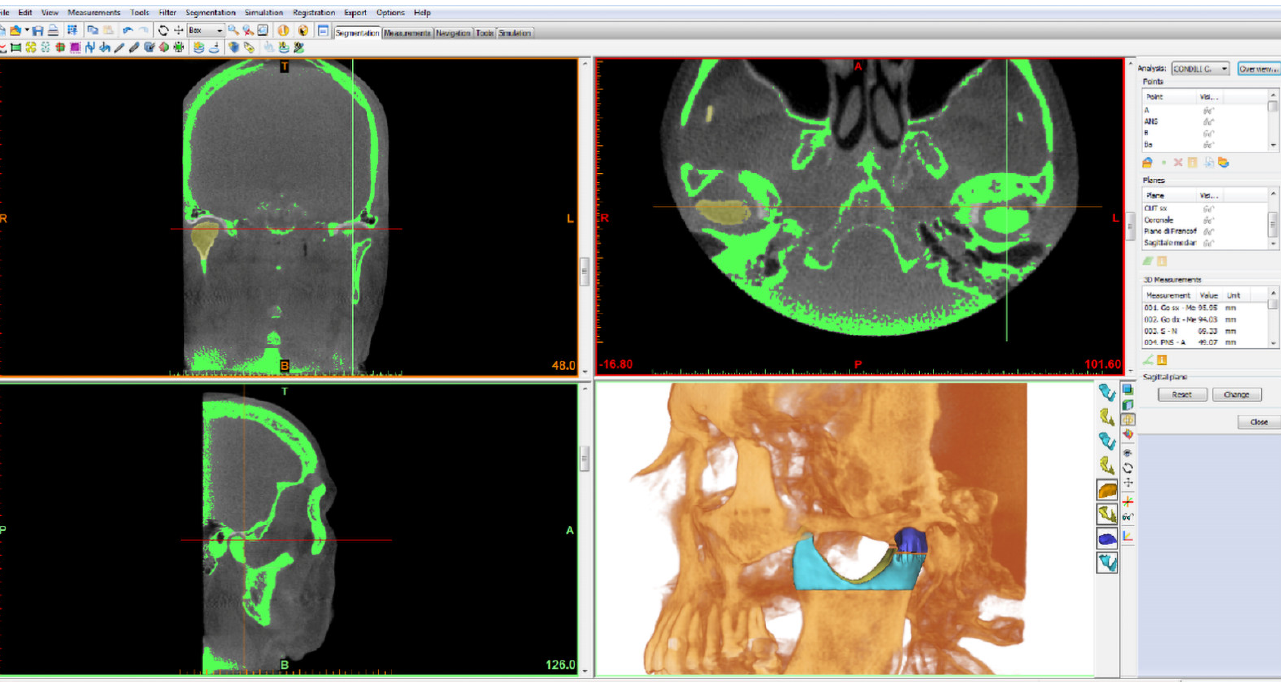
Figure 3. The rendering of the condylar head (blue) and the volume of the condyle portion below (light blue) are visible in the image.